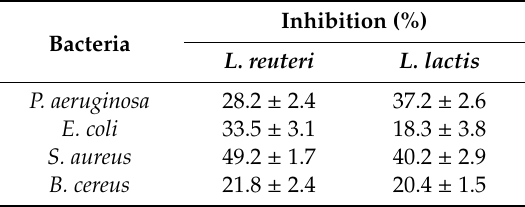
Table 5. Inhibitory property of LAB on